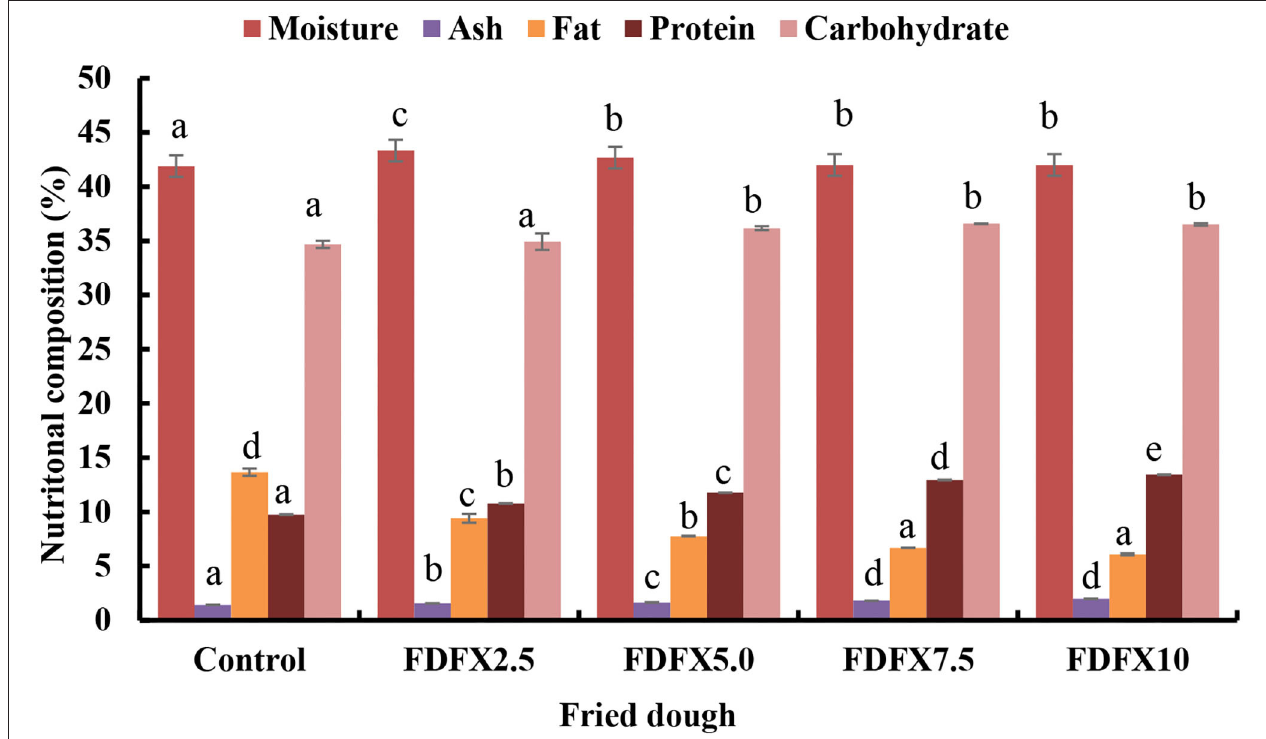
FIGURE 4 | Nutritional composition of flaxseed-enriched fried dough. Results were presented as mean ± standard deviation ( n = 3). Superscripts were assigned to show significant differences ( p < 0.05) with an increase in egg in similar bars using Duncan multiple range test. FDFX = flaxseed-enriched fried